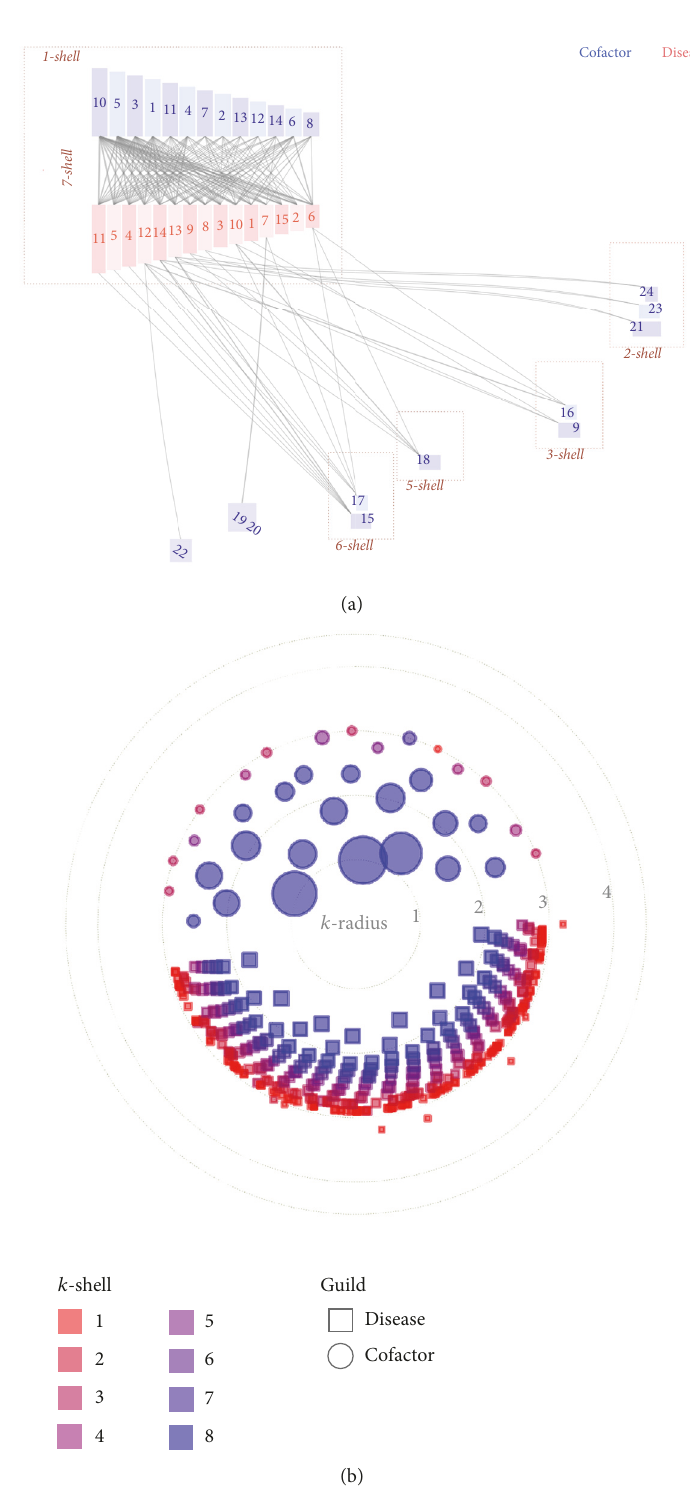
Figure 7: Disease-cofactor network [33]. (a) Ziggurat plot of the subset. (b) Polar plot of the full